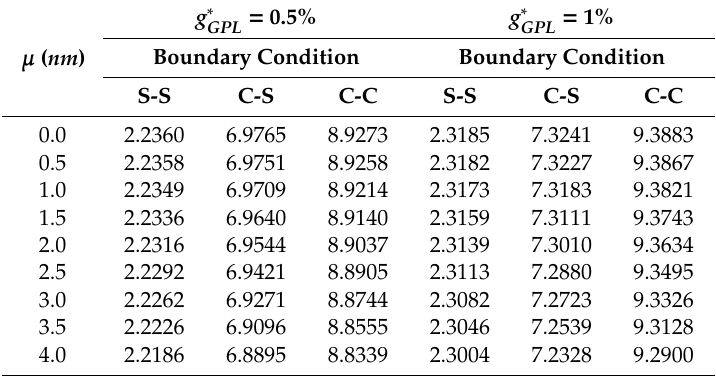
Table 4. Variation of the first natural frequency for FG curved nanobeams with di ff erent nonlocal parameters, weight fractions, and boundary conditions.